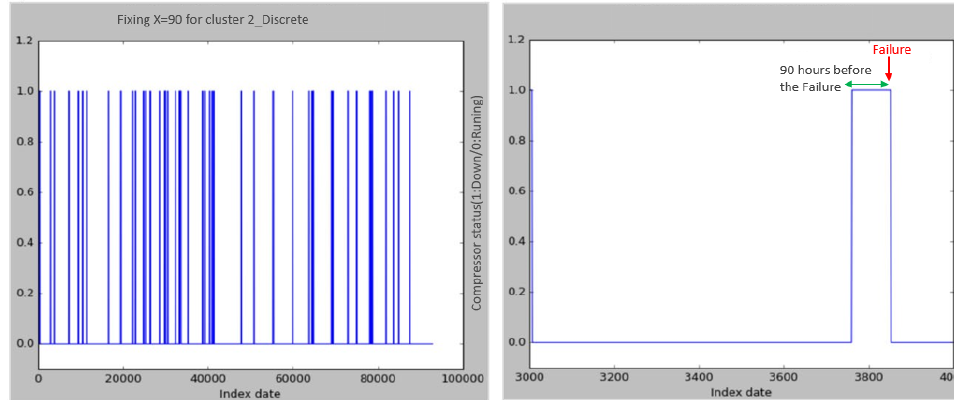
Figure 11. Example of the fixing method for X = 90 h for the 2-discrete cluster .